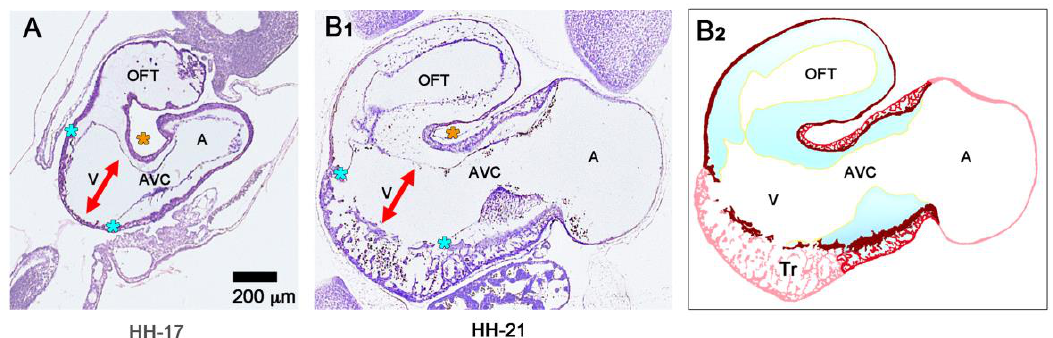
Figure 14. These histological sections from embryonic chick hearts depict the changes in the ventricular wall architecture during the advanced phase of ventricular tube remodeling. ( A ) At the time point of the transition from the initial to the advanced phase of ventricular tube remodeling (HH-stage 16/17), the outer curvature of the ventricular bend lacks a CJ layer and the tips of the endocardial projections of the trabecular shields are in direct contact to the basal layer of the ventricular myocardium (blue asterisks mark the proximal and distal borders of the trabecular shields; orange asterisk marks the inner curvature of the ventricular bend). In the AVC, endocardium-derived mesenchyme has started an invasion of the CJ. Note that the myocardial walls of all portions of the primary ventricular tube have a tubular shape. ( B 1 ,B 2 ) HH-stage 21. Due to the formation of trabeculated embryonic ventricles, the outer contour of the ventricular bend has lost its original tubular shape. The AVC and OFT have preserved their original tubular shapes. When looking on the inner structure of the embryonic ventricles, however, it becomes apparent that the original tubular shape of the ventricular bend is still visible if one follows an imaginary line that connects the free edges of the myocardial trabeculae (highlighted by the dark red color in ( B 2 ). Note that the free lumen of the embryonic ventricles does not change significantly between HH-stages 17 and 21. Note also the structural similarity between the non-trabeculated, three-layered myocardium of the AVC (inner compact layer, reticular layer, outer compact layer) and the trabeculated myocardium of the embryonic ventricles. Color code used in ( B 2 ): dark red = remnants of the inner layer of the primary ventricular myocardium; red = reticular and outer compact myocardium of the AVC; light red = trabeculated and outer compact myocardium of embryonic ventricles, and atrial myocardium; light blue = CJ and intramyocardial ECM; yellow = endocardium. Abbreviations: A = primary atrium; AVC = atrio-ventricular canal; OFT = outflow tract; Tr = trabecular layer of ventricular myocardium; V = free lumen of the primary ventricular tube.